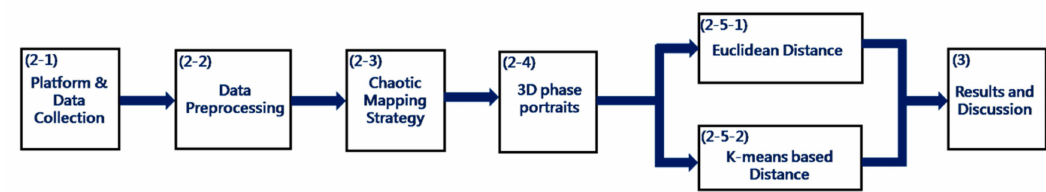
Figure 1. The flowchart of the proposed smart fault detection machine.